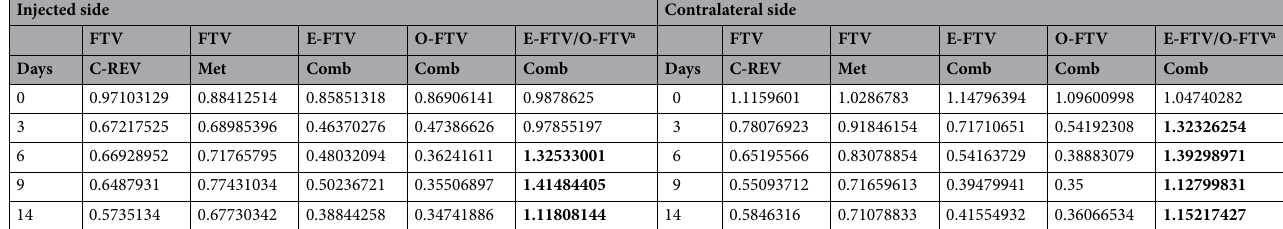
Table 1. Fractional tumor volume (FTV) after treatment with C-REV, either alone or in combination with metformin. FTV, fractional tumor volume (mean tumor volume experimental/mean tumor volume control); E- FTV, expected FTV (mean FTV of C-REV) × (mean FTV of metformin); O-FTV, observed FTV. a Synergic effect: E-FTV/O-TV>1 in